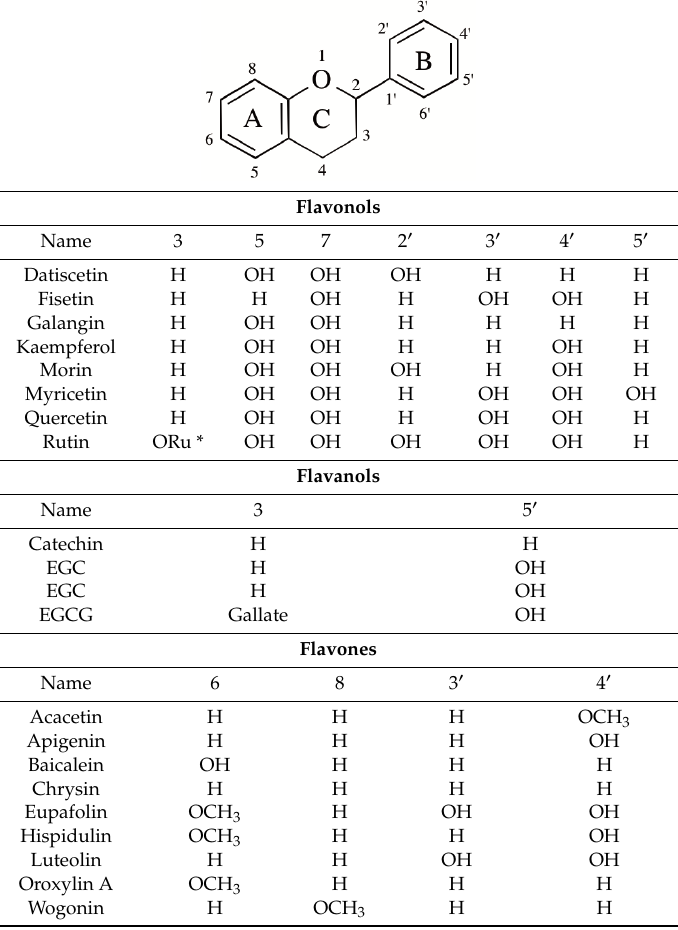
Table 1. Chemical structure of cited flavonoids. * O-rutinoside.